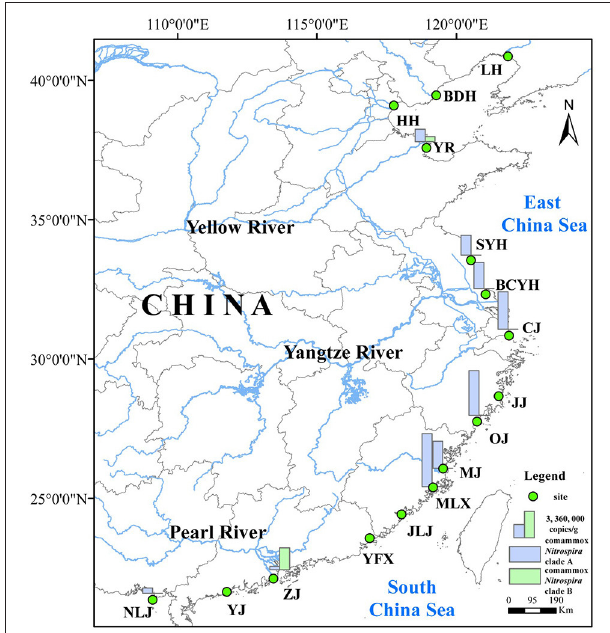
FIGURE 1 | Location of sampling sites in the estuarine tidal flat wetlands of